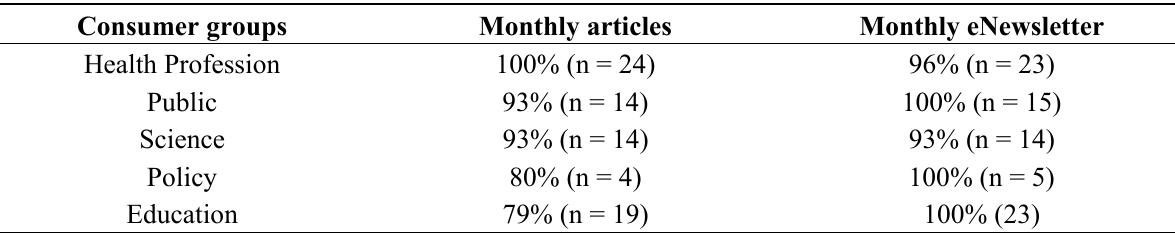
Table 2. Respondents reading monthly articles and